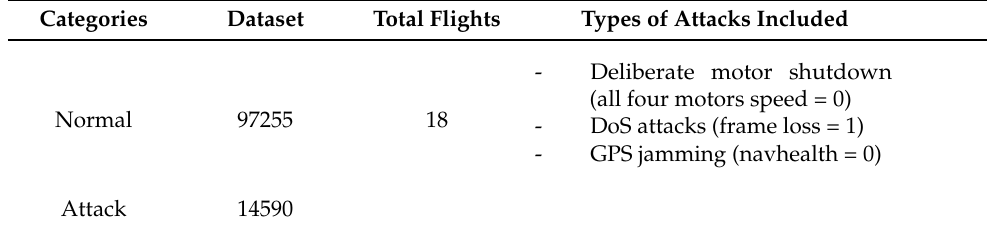
Table 3. Dataset